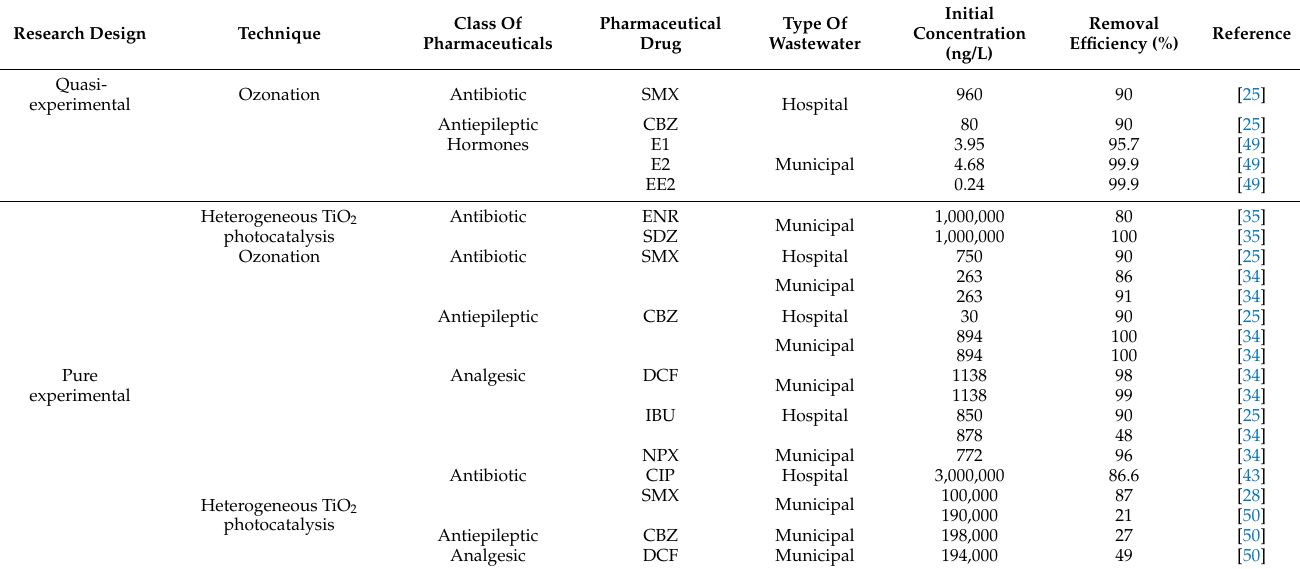
Table 5. Removal of pharmaceuticals by chemical treatment